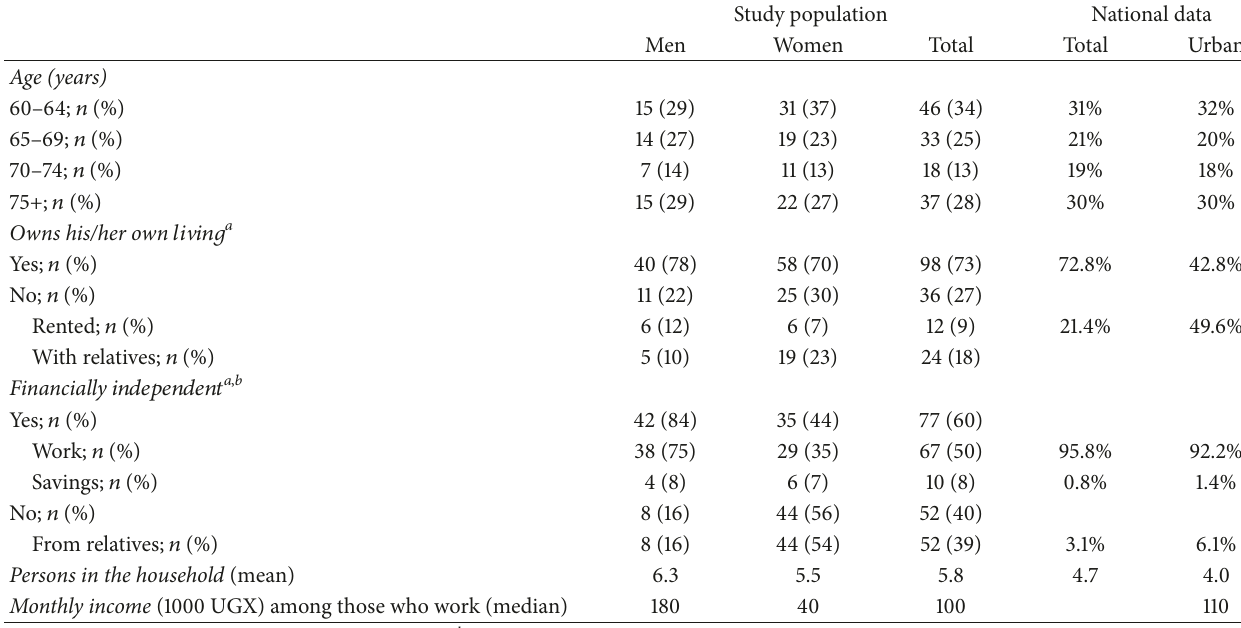
Table 1: Sociodemographic characteristics of the 134 study participants and national data [7,